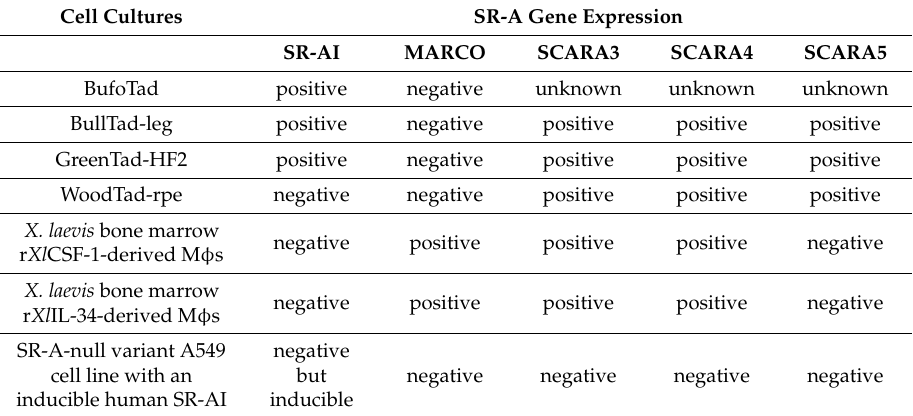
Table 2. Profiles of SR-A gene expression in tadpole-derived cell